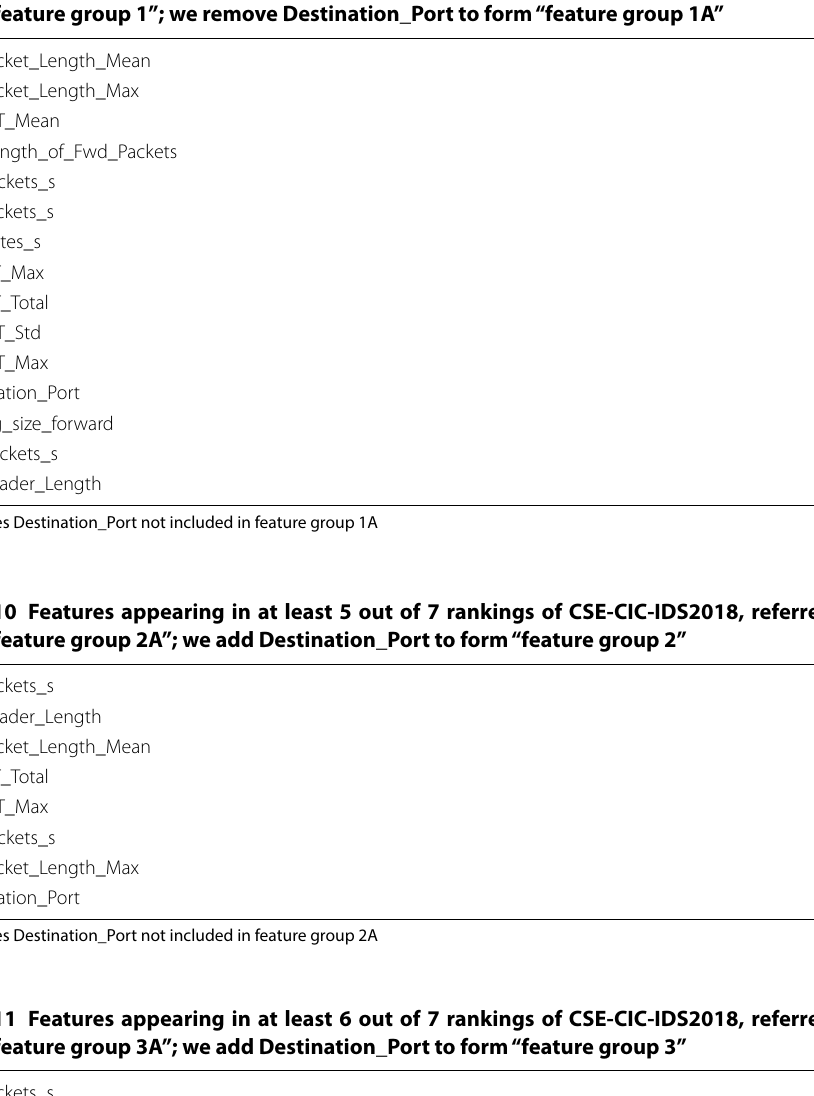
Table 9 Features appearing in at least 4 out of 7 rankings of CSE-CIC-IDS2018, referred